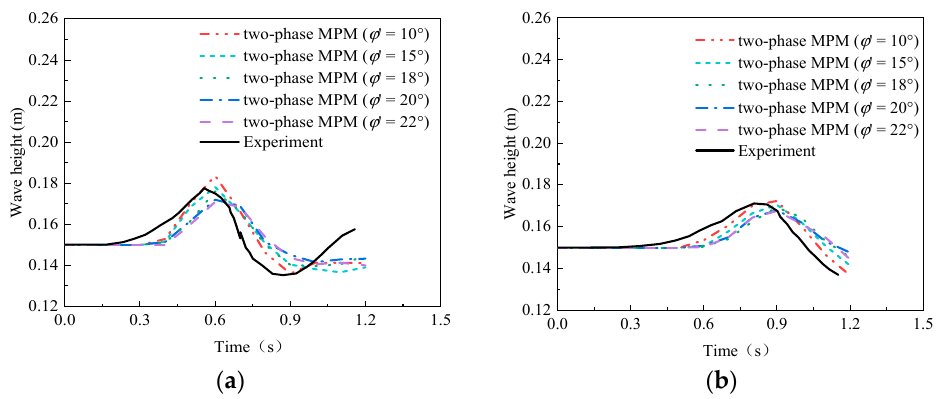
Figure 10. In fl uence of internal friction angle of sliding sand: time history curve of the free water surface at two di ff erent locations: ( a ) X1 = − 0.3 m; ( b ) X2 = − 0.6 m.